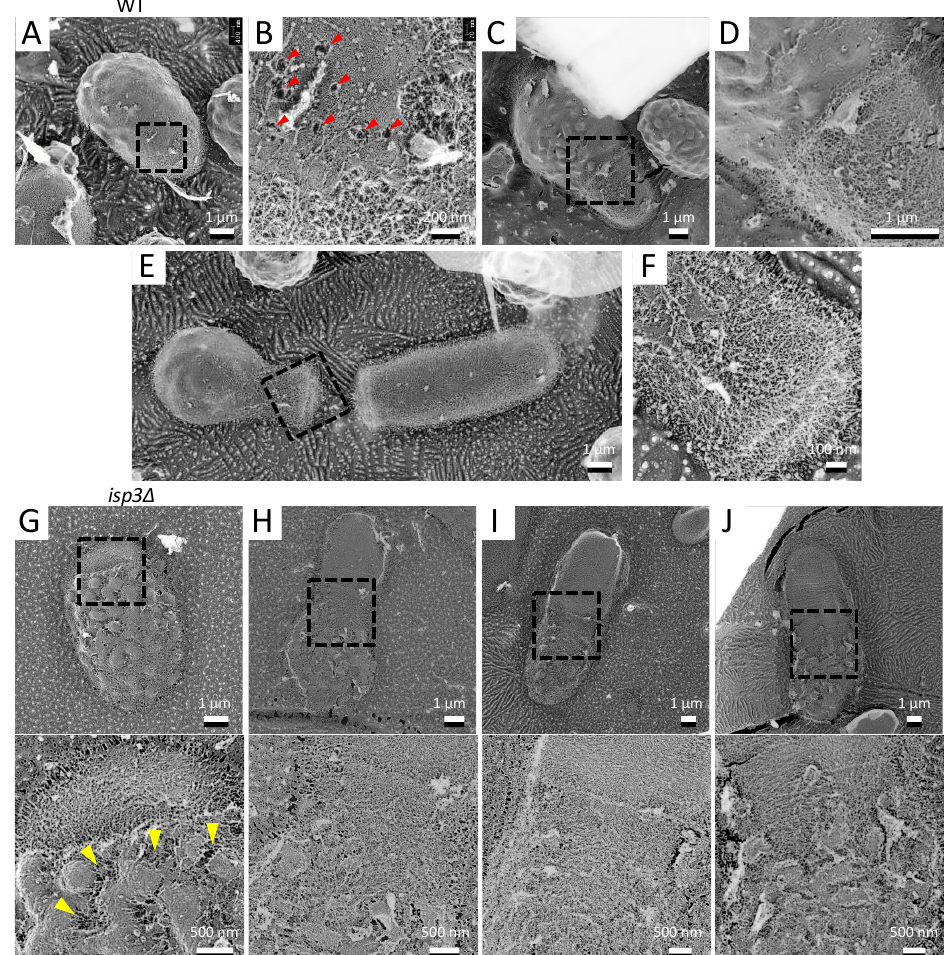
Figure 4. Morphological changes on the spore surface during germination. ( A ) Spore germination of a wild-type cell. ( B ) Magnified image of the boxed region in A. Arrowheads indicate the holes. ( C ) Spore in which germination is proceeding. ( D ) Magnified image in the boxed region in ( C ). ( E ) Image of the first cell division after germination. ( F ) Magnified image of the boxed region in ( E ). ( G – J ) Top panels, isp3Δ spore germination. Bottom panels, magnified images of the boxed regions above. Arrowheads indicate the collapsed regions of the spore wall.